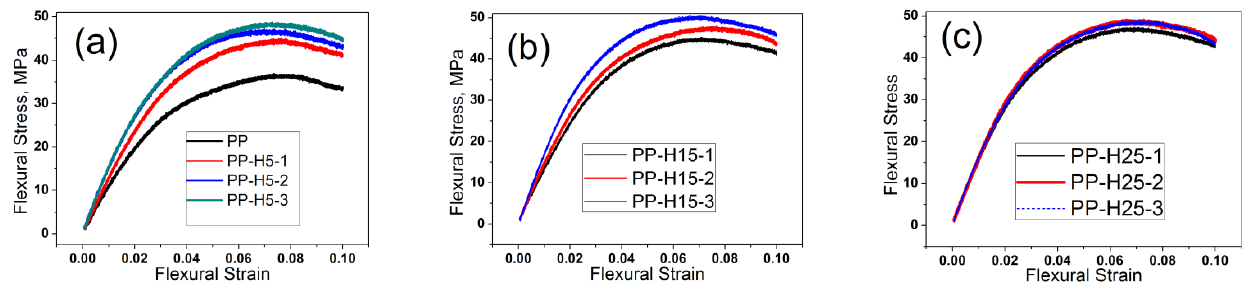
Figure 4. Relationship between flexural stress and strain ( a ) PP and PP-H5, ( b ) PP-H15 and ( c ) PP-H25 systems at 10% flexural extension.